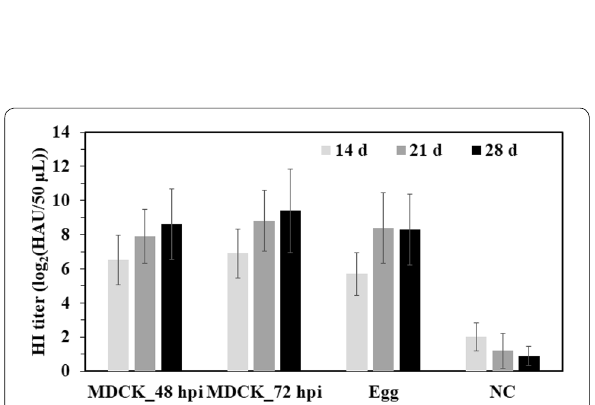
Fig. 6 Immunogenicity of the MDCK cell‑derived H9N2 vaccines compared to egg‑derived vaccines. The inactivated MDCK cell‑derived H9N2 vaccines prepared by the virus harvested at 48 hpi or 72 hpi and inactivated egg‑derived H9N2 vaccines were injected to 3‑week‑old SPF chickens. HI activity of chicken serum against H9N2 vaccines collected on day 14 (light gray column), day 21 (dark gray column), and day 28 (black column) was